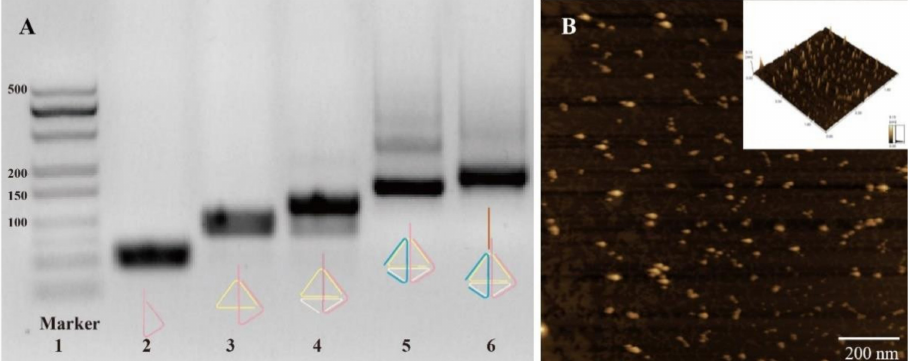
Figure 3. Characterization of the Td. ( A ) 3% agarose gel electrophoresis (AGE) image of Td: lane 1: DNA Marker, lane 2: T1 strand, lane 3: T1 + T2, lane 4: T1 + T2 + T3, lane 5: Td, lane 6: Td1; ( B ) AFM result of Td (Inset: size distribution of